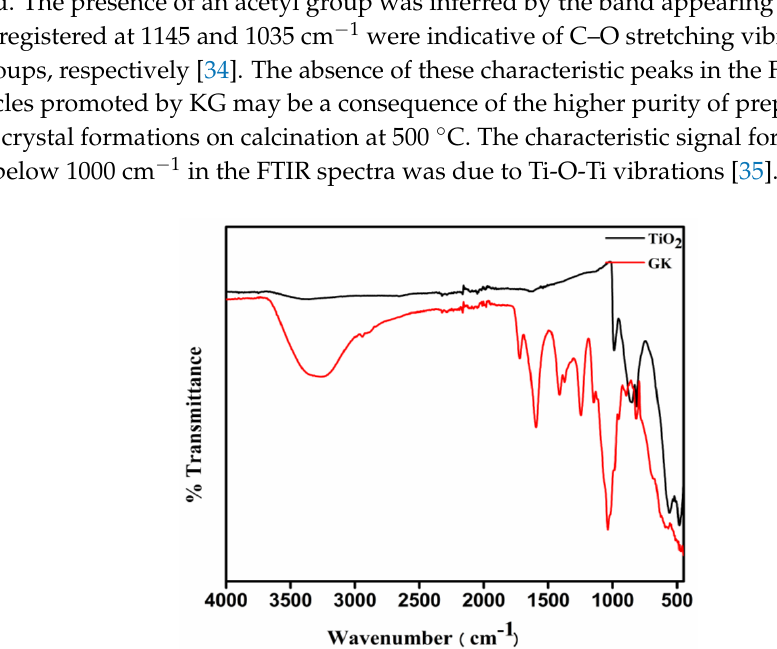
Figure 2. XRD pattern of TiO 2 nanoparticles calcined at different temperatures (R denotes rutile and A denotes anatase phases of TiO 2